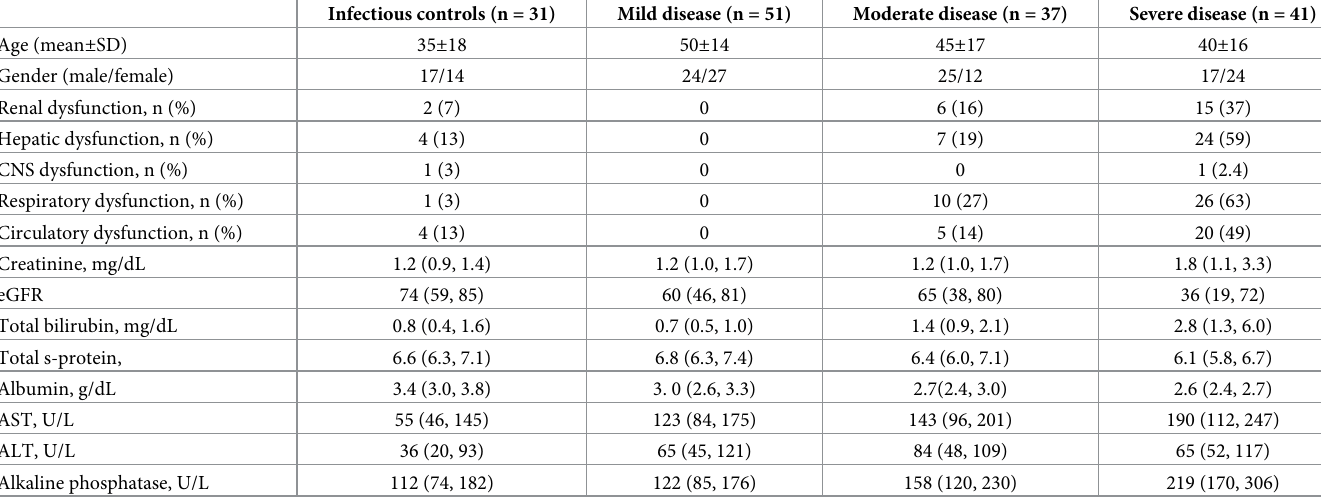
Table 1. Characteristics of patients with scrub typhus according to disease severity and infectious disease controls.